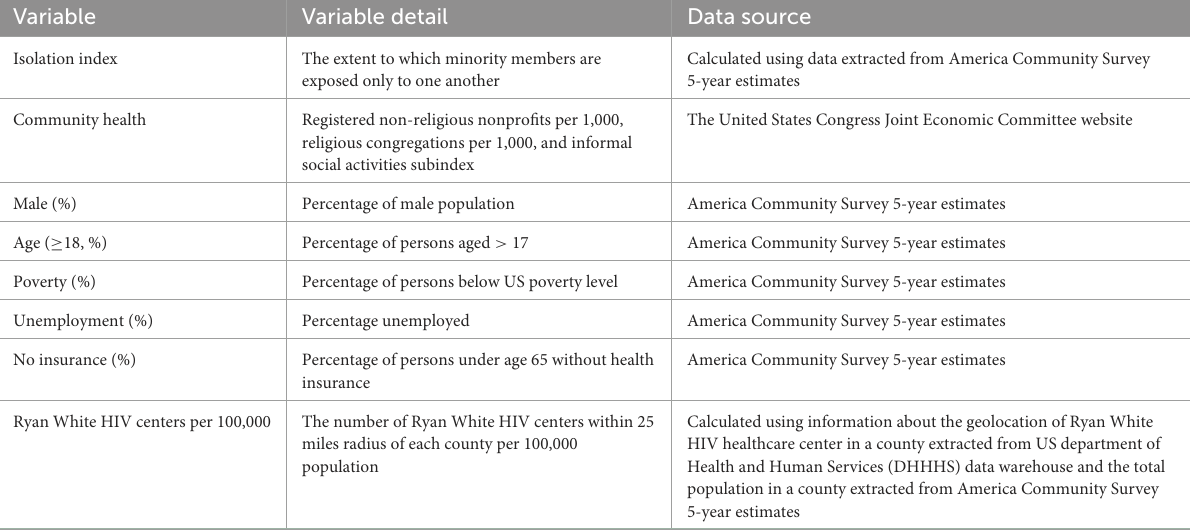
TABLE 1 The detailed description of each variable and data